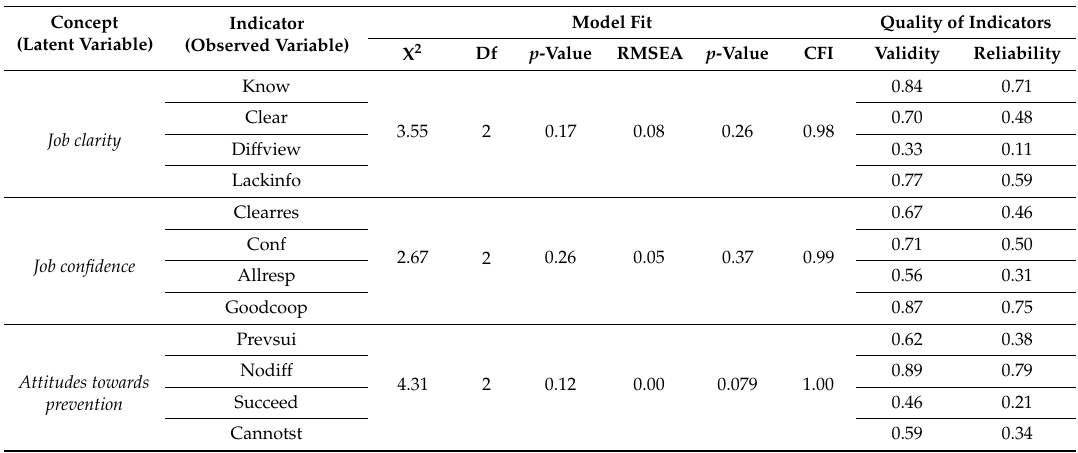
Table 1. Validity and reliability for indicators in the concepts Job clarity , Job confidence and Attitudes towards